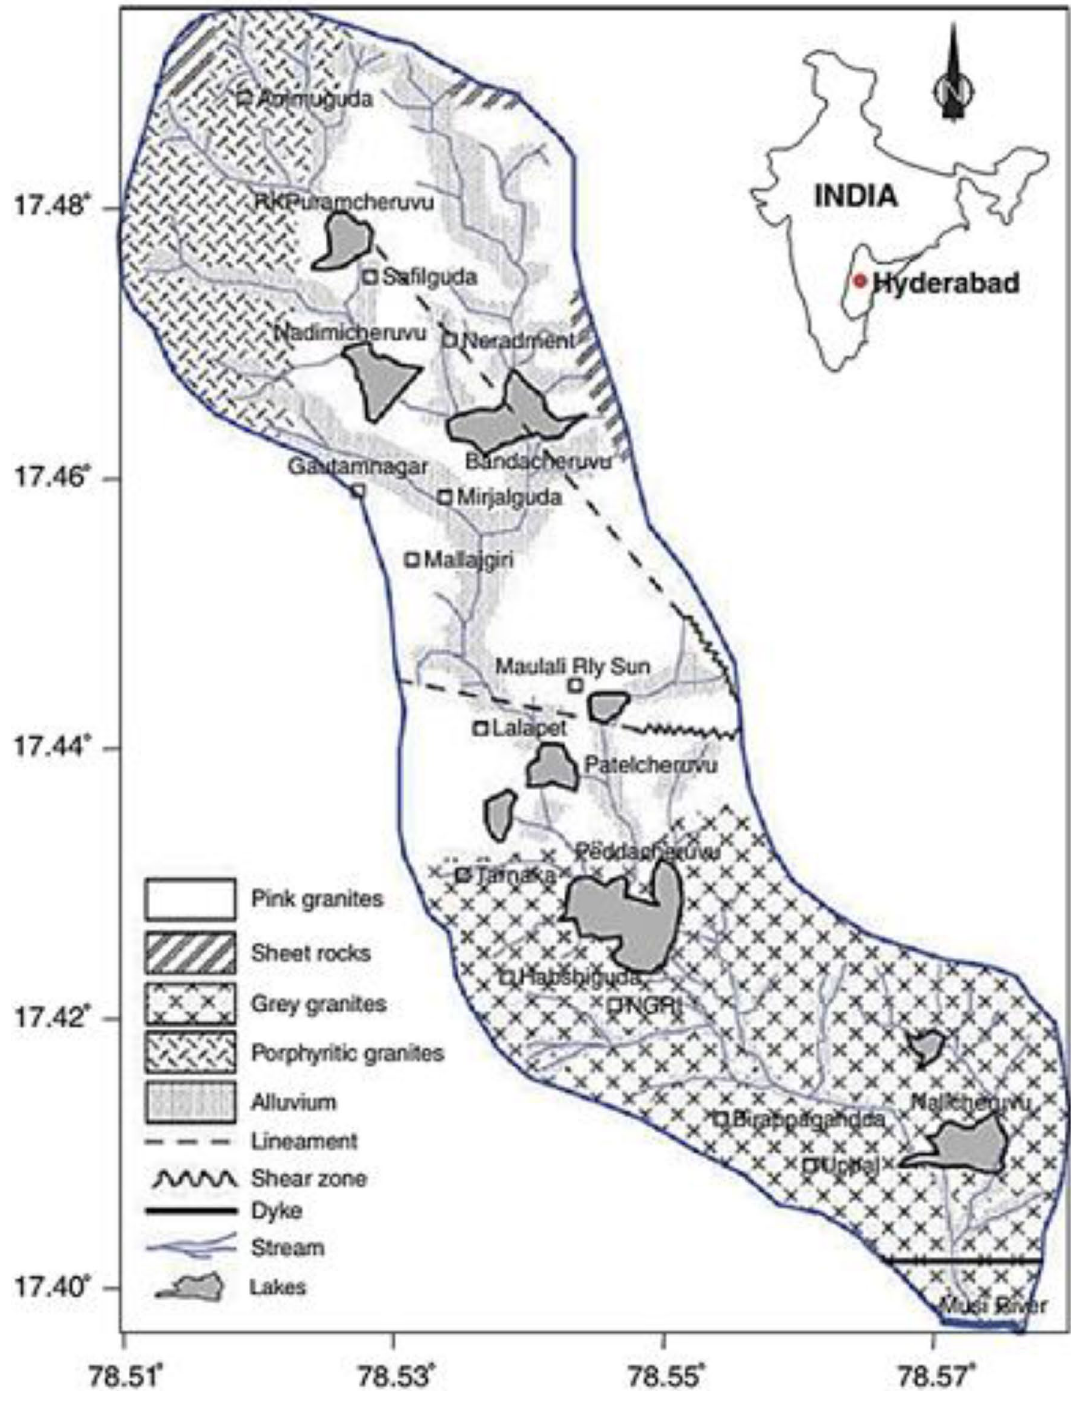
Fig. 1 Location and geology map of the study